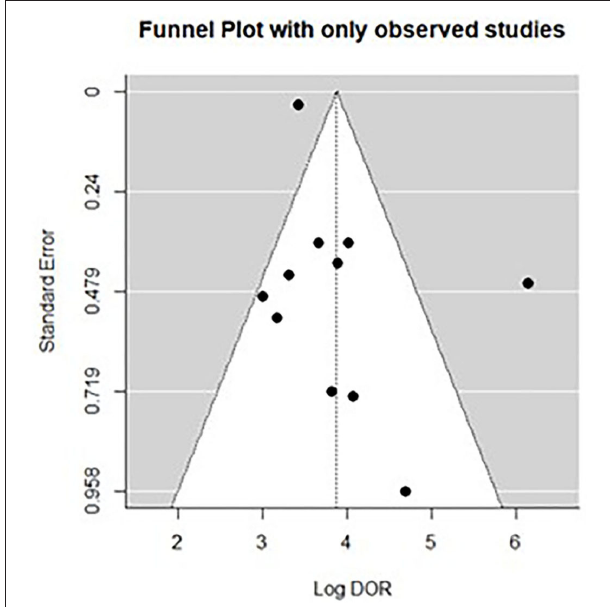
FIGURE 6 | Funnel plots of all included studies.